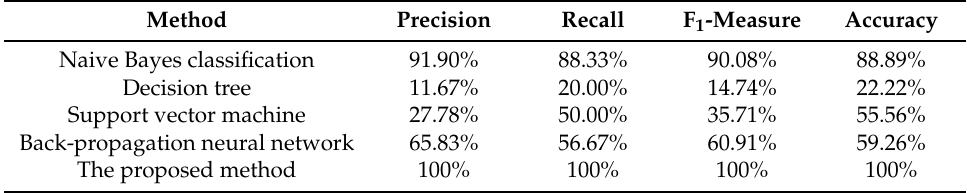
Table 4. The comparisons of different machine learning methods with all features for vehicle positioning.